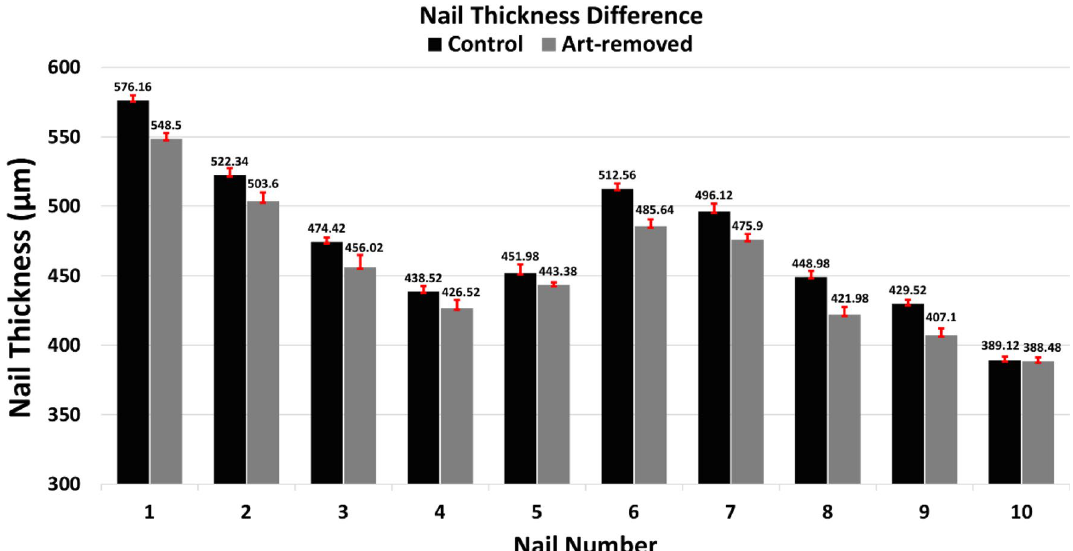
Figure 10. Graphical representation of the thickness difference of control and art-removed nails.